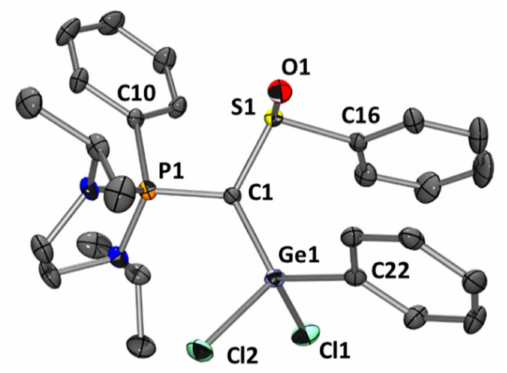
Figure 3. Molecular structure of 7 . Ellipsoids are drawn at the 30% probability level; hydrogen atoms are omitted for clarity. Selected bond lengths (Å) and angles ( ◦ ): P1-C1 1.707(3),